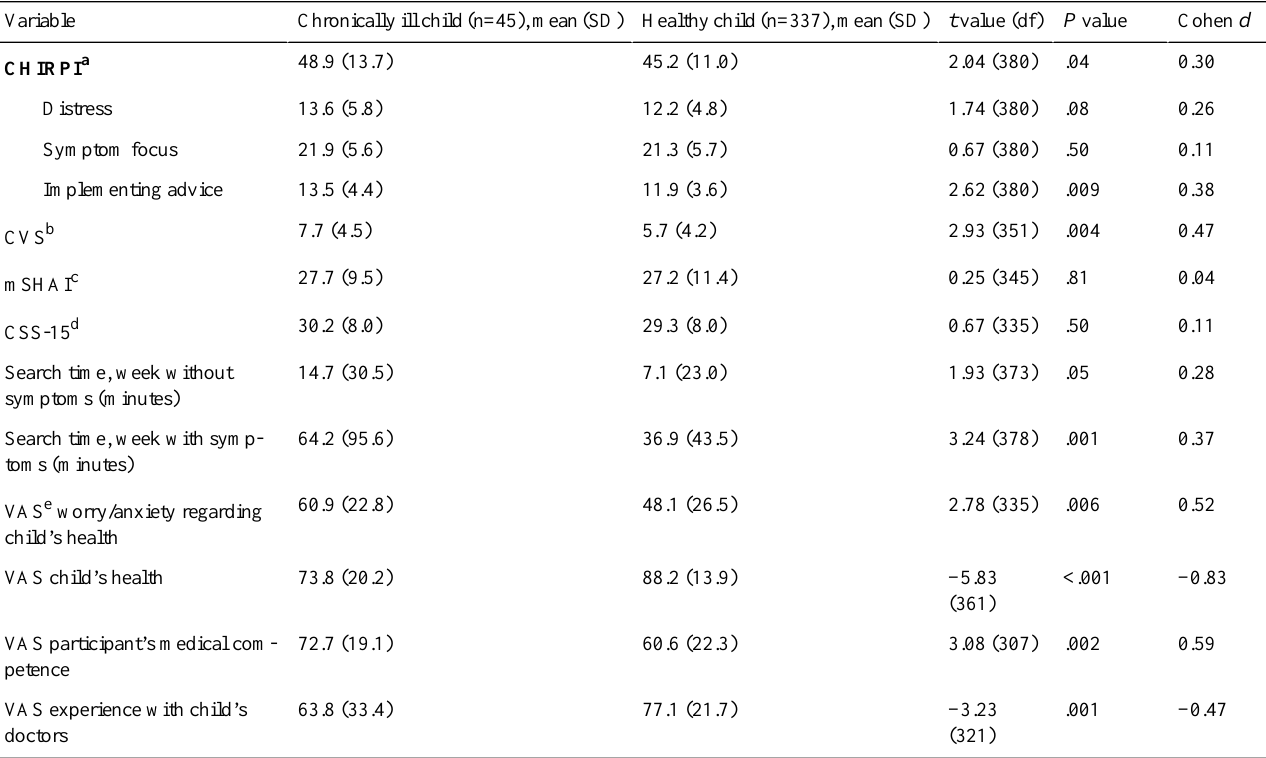
Table 5. Comparisons of parents with chronically ill children and parents with healthy children by means of independent samples t